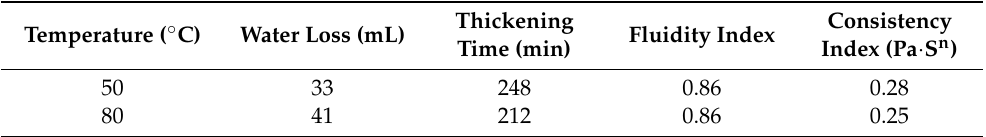
Table 3. Construction performance of cement slurry.